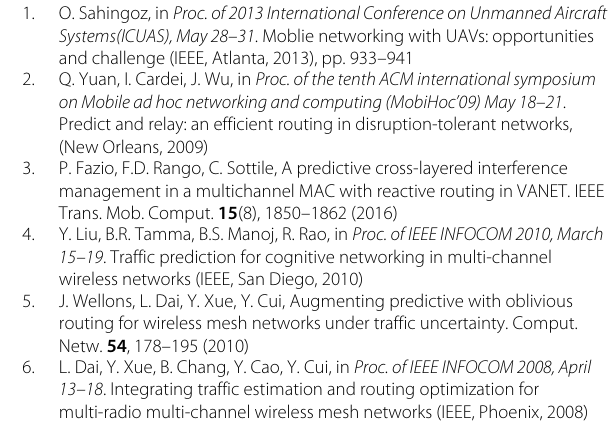
variations are caused by different network states at differ- ent timescales, and there are additional research opportu- to adapt the network